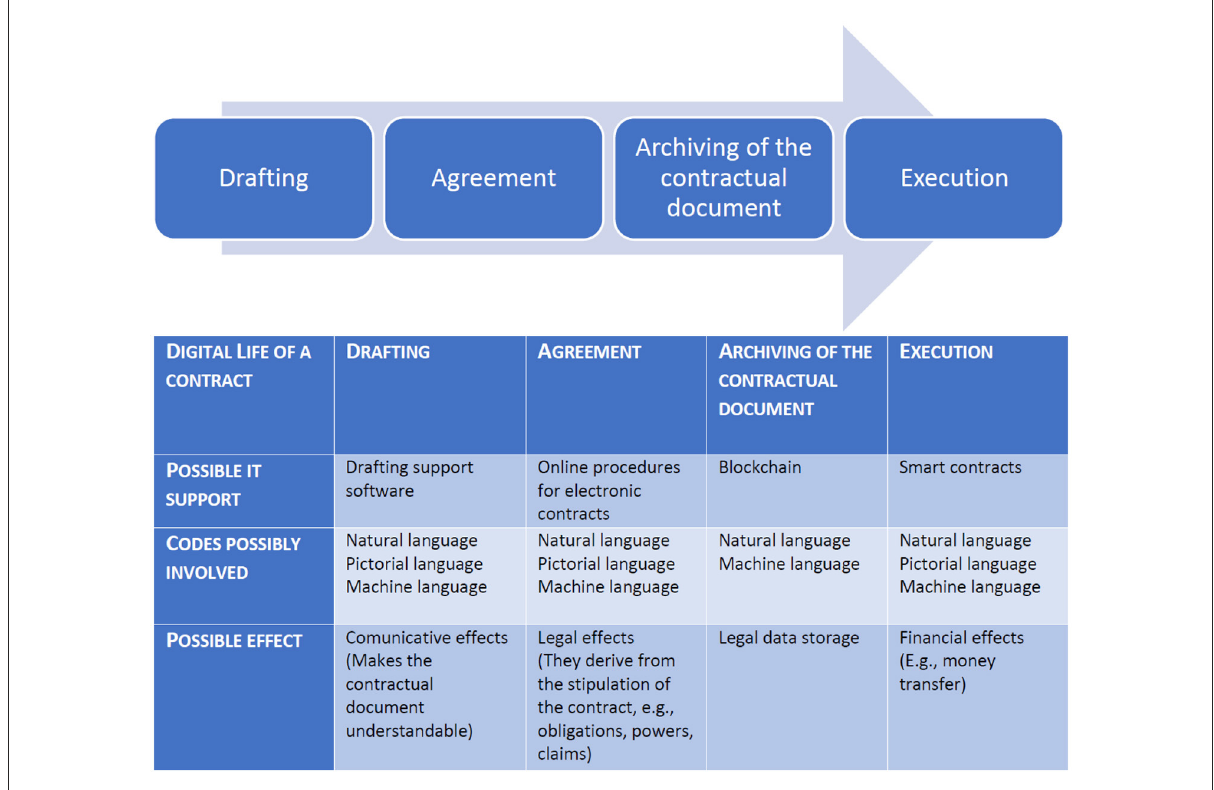
FIGURE1 The digital management of a